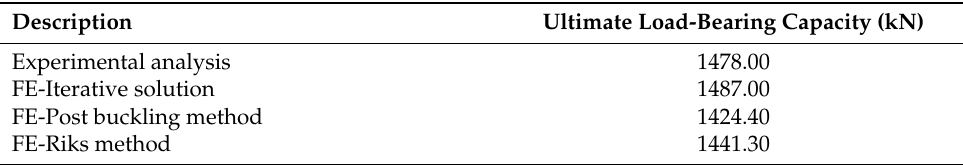
Table 3. Maximum load-bearing capacities for different FE